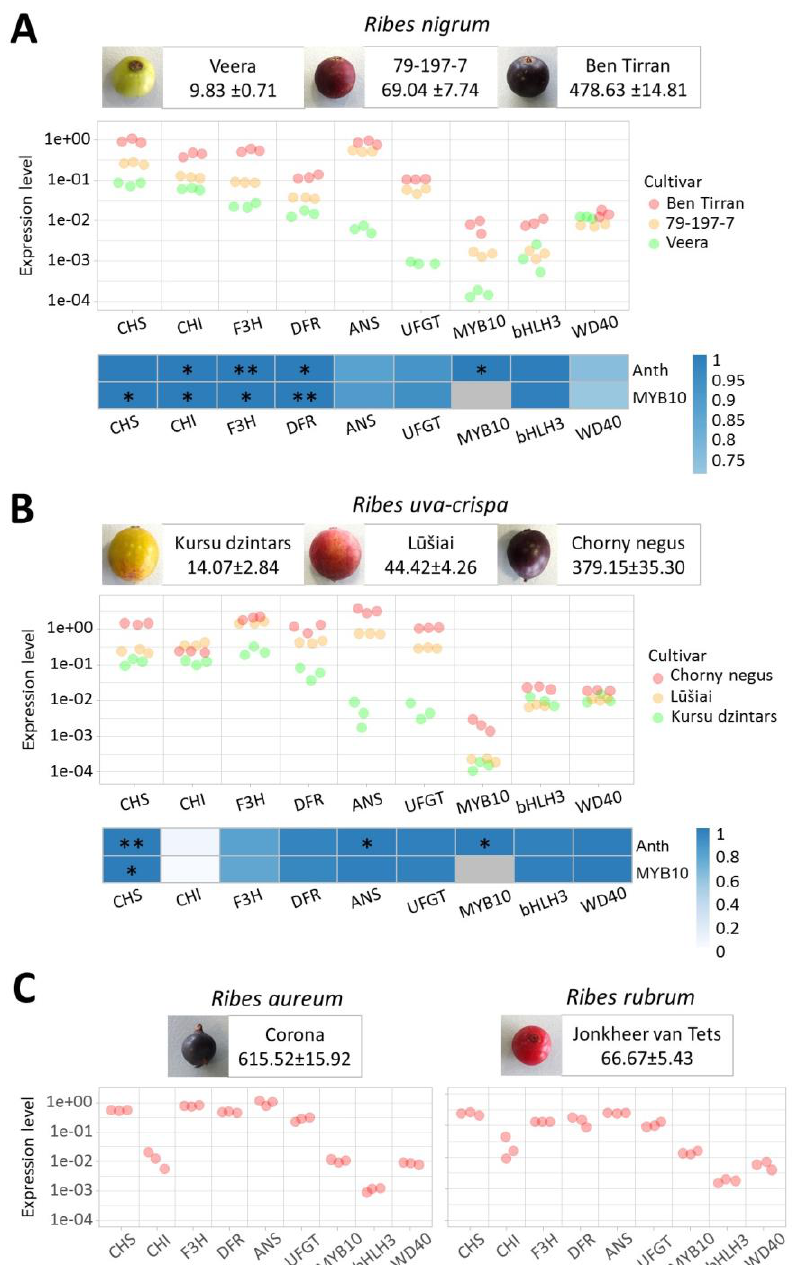
Figure 5. Expression of flavonoid pathway genes in fruits of different Ribes cultivars. For each species, ripe fruits with specified total anthocyanin content in mg/100 g of fresh fruit weight are shown at the top, qPCR expression data in the middle and Pearson correlation analysis of expression levels of each gene and anthocyanin content (Anth) or MYB10 expression level at the bottom. Each point in the gene expression dot plots represents the average of three technical replicates. All expression data are presented on a logarithmic scale and normalized by the level of control gene expression. The statistical significance of Pearson correlation is denoted as: *, p value ≤ 0.05; **, p value ≤ 0.01. ( A ) Three Ribes nigrum cultivars with different anthocyanin levels. ( B ) Three Ribes uva-crispa cultivars with different anthocyanin levels. ( C ) Ribes rubrum cultivar “Jonkheer van Tets” and Ribes aureum cultivar “ Corona ” .